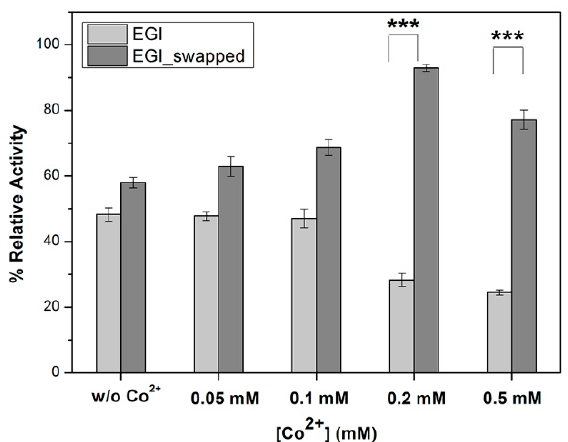
Figure 3. The effects of Co 2+ -ion pre-incubation with enzymes prior to hydrolysis reaction on their enzymatic activity profiles. Through enzyme assays toward 0.5% w/v CMC, the impacts of Co 2+ ion pre-incubation with enzymes were investigated for different Co 2+ ion concentrations, 0 mM, 0.05 mM, 0.1 mM, 0.2 mM and 0.5 mM, in final. The highest data among all activity tests, EGI_swapped at 50 ◦ C for 6 h, is taken as 100% to calculate the rest. Data are express as mean ± SD, n = 3. To indicate the significant differences in enzymatic activities of EGI and EGI_swapped enzymes, p -value smaller than 0.001 are indicated with ‘***’ on